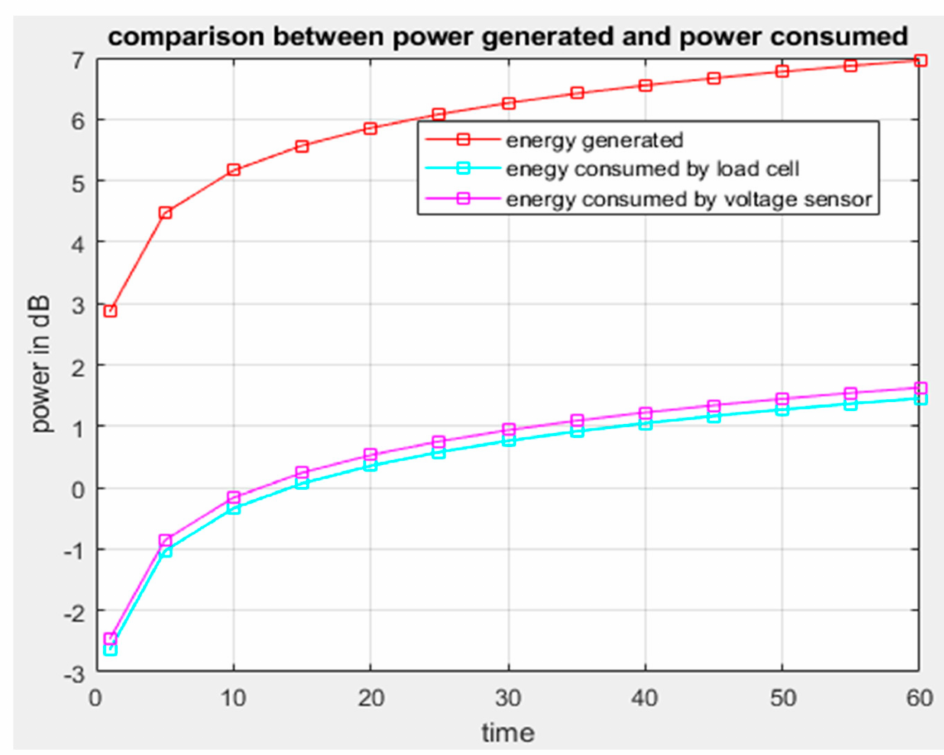
Figure 12. Graph comparing generated power and power